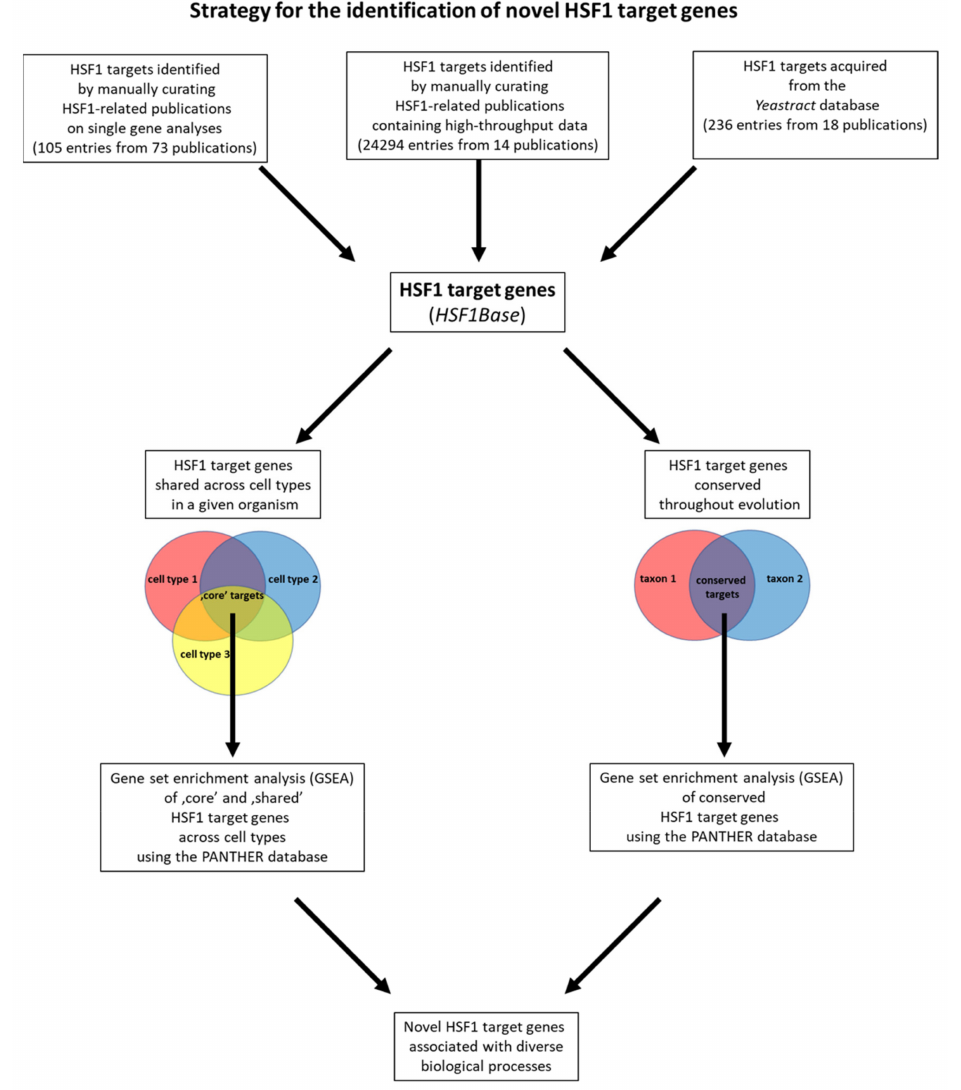
Figure 1. A flowchart depicting our strategy for the identification of novel potential HSF1 target genes. The database (HSF1Base) was built by manually curating HSF1-related publications on single gene analyses (105 entries from 73 publications), HSF1-related publications containing high-throughput data (24,294 entries from 14 publications) and acquiring HSF1 targets from Yeastract database (236 entries from 18 publications). Out of all target genes contained in our database we selected those shared across cell types in each organism. Then, we performed gene set enrichment analysis (GSEA) using PANTHER database on the ‘core’ (shared between all three cell types) and ‘shared’ (shared between at least two cell types) gene sets. We also selected evolutionally conserved target genes and performed GSEA using the PANTHER database on these target genes as well. We then identified novel HSF1 target genes associated with diverse biological processes of